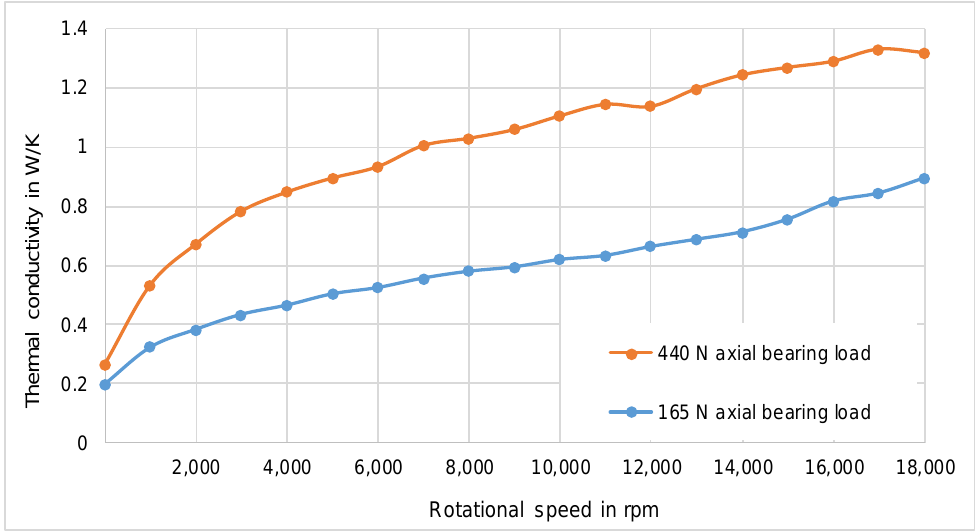
Figure 22. Thermal conductance of an SKF 71908 CEGA/HCP4A bearing grease lubricated with SKF LGLT2 as a function of rotational speed for two different axial loads.